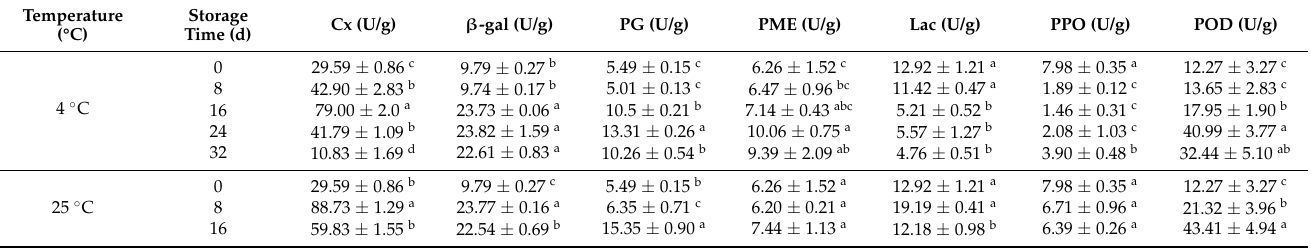
Table 2. Changes in enzymes related to cell wall metabolism of Z. latifolia during